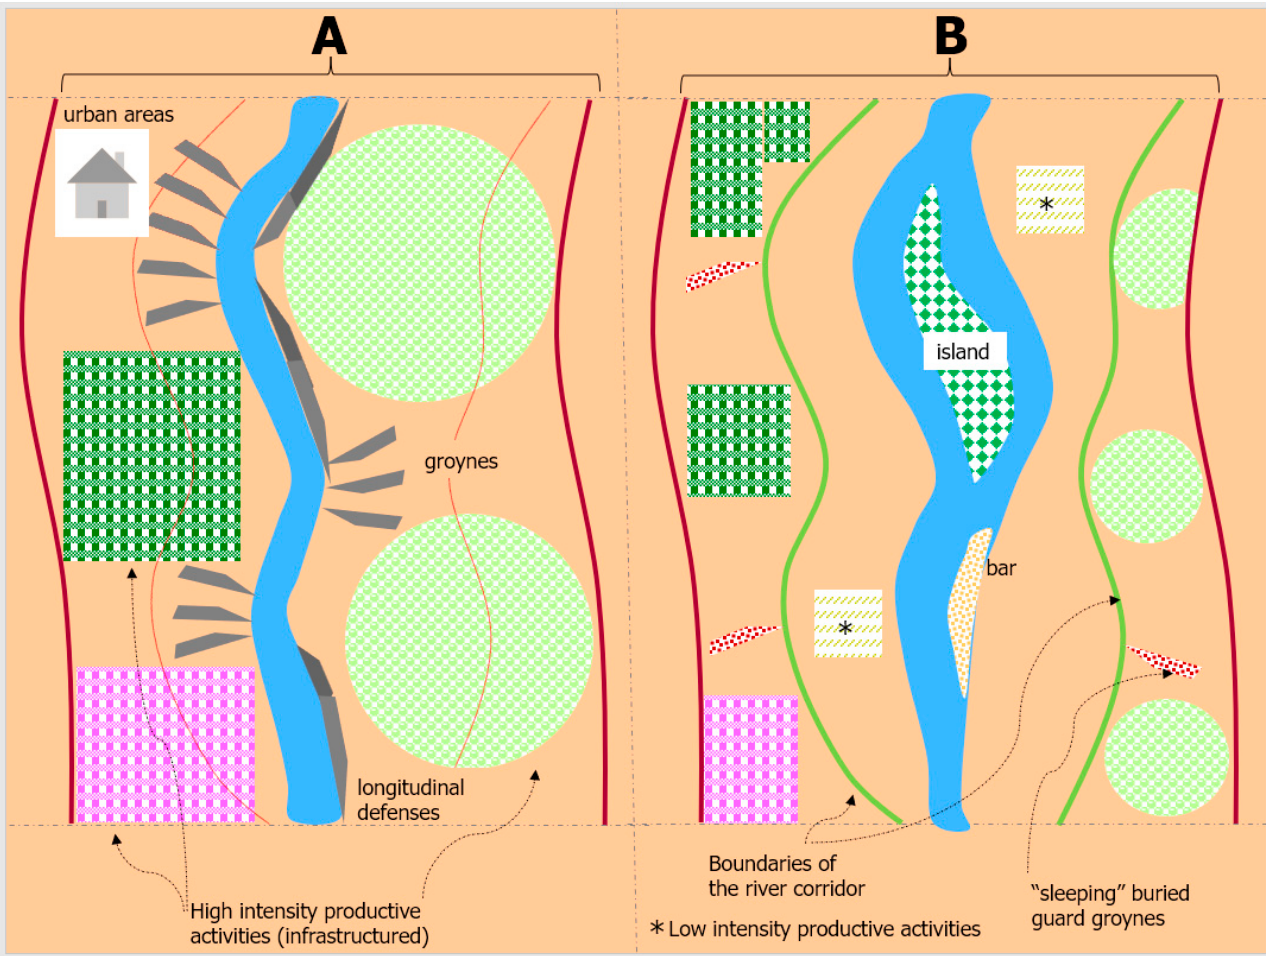
Figure 9. The paradigm shift: ( left ) typical present situation ( A ) of a river reach with heavy grey defenses, close-by urban areas, and the whole territory intensely utilized for agricultural and indus- trial purposes; ( right ) a wide river corridor ( B ) recreated in which the river can wander, meander or avulse so finding its own river style and recreating the suited geomorphic units (bars, islands, or oxbows, etc.), within a wide space delimited by clear boundaries (green lines; possibly not so external as the natural ones), defended by guard defense works (groynes generally buried or modest levees), coming into action only in case of an attempt to escape the boundaries; and where land uses have been modified, reducing the space occupied by those still inside the corridor and/or switching them to flood compatible types (indicated by *).